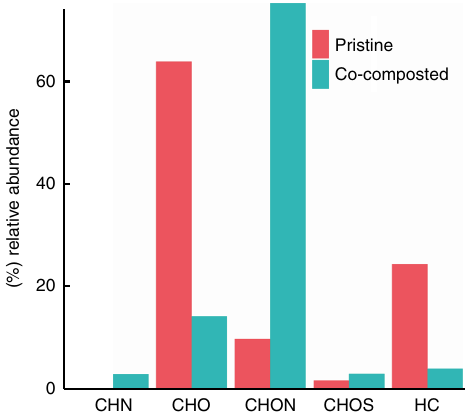
Fig. 3 In situ characterization of the organic coating by DAPPI FT-ICR MS.